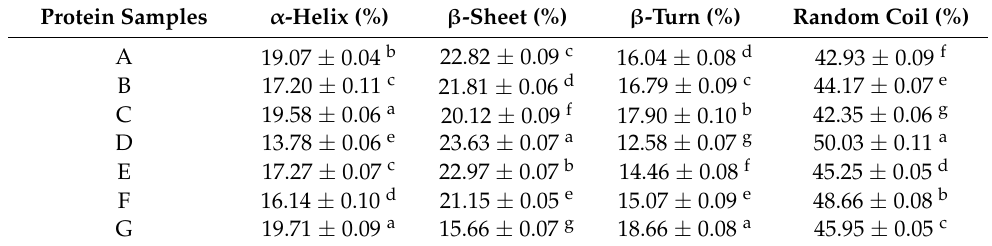
Table 4. The secondary structure content of oxidized SPI before and after cavitation jet treatment. Protein Samples